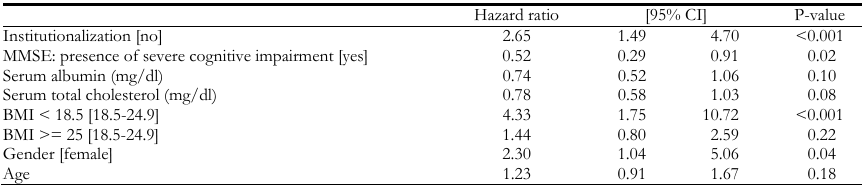
Variables predicting survival after 98 years of age. Synthetic